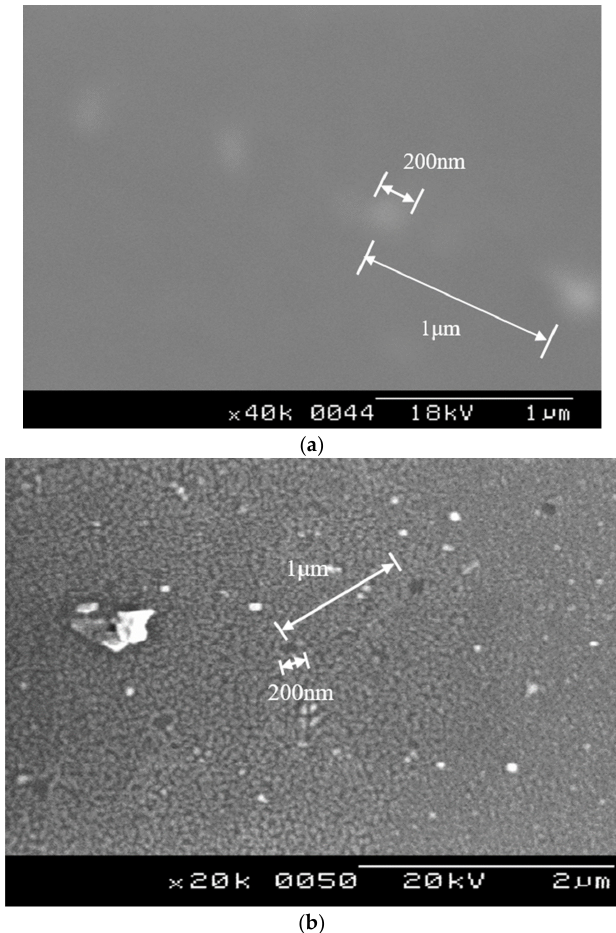
Figure 6. Laser-based capture of particles for 0.001 M concentration, 30 μ m thick transfer films. Particle capture on the 20 nm thick monolayer of gold particles was performed using the prepared transfer film. The diameter of the melted spot on the film was 200 nm, as shown in ( a ), while the hole size on the monolayer was 200 nm, as shown in ( b ). Particles with diameters of 200 nm were successfully captured.